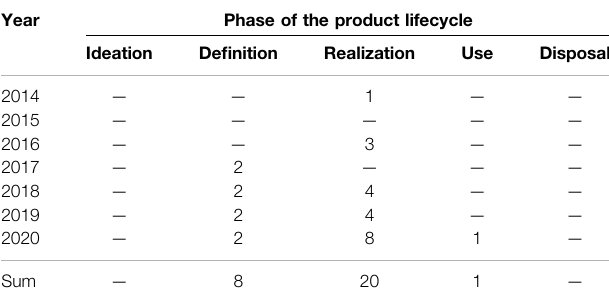
TABLE 4 | Phase of the product lifecycle and year of the